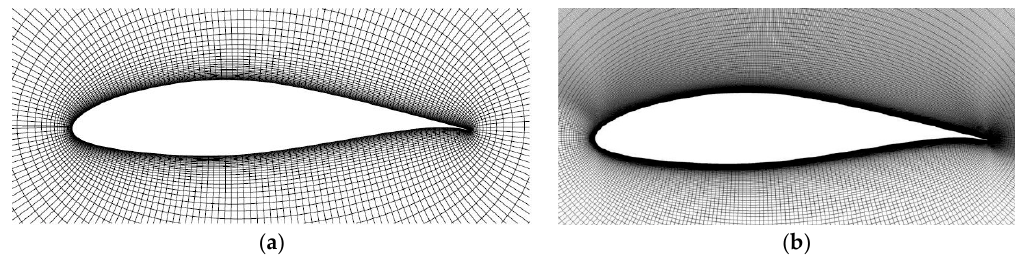
Figure 6. Computational grid for ( a ) Re = 64,200 and ( b ) Re = 300,000 simulation (every fourth grid line is shown). (Reprinted from [31,33]).